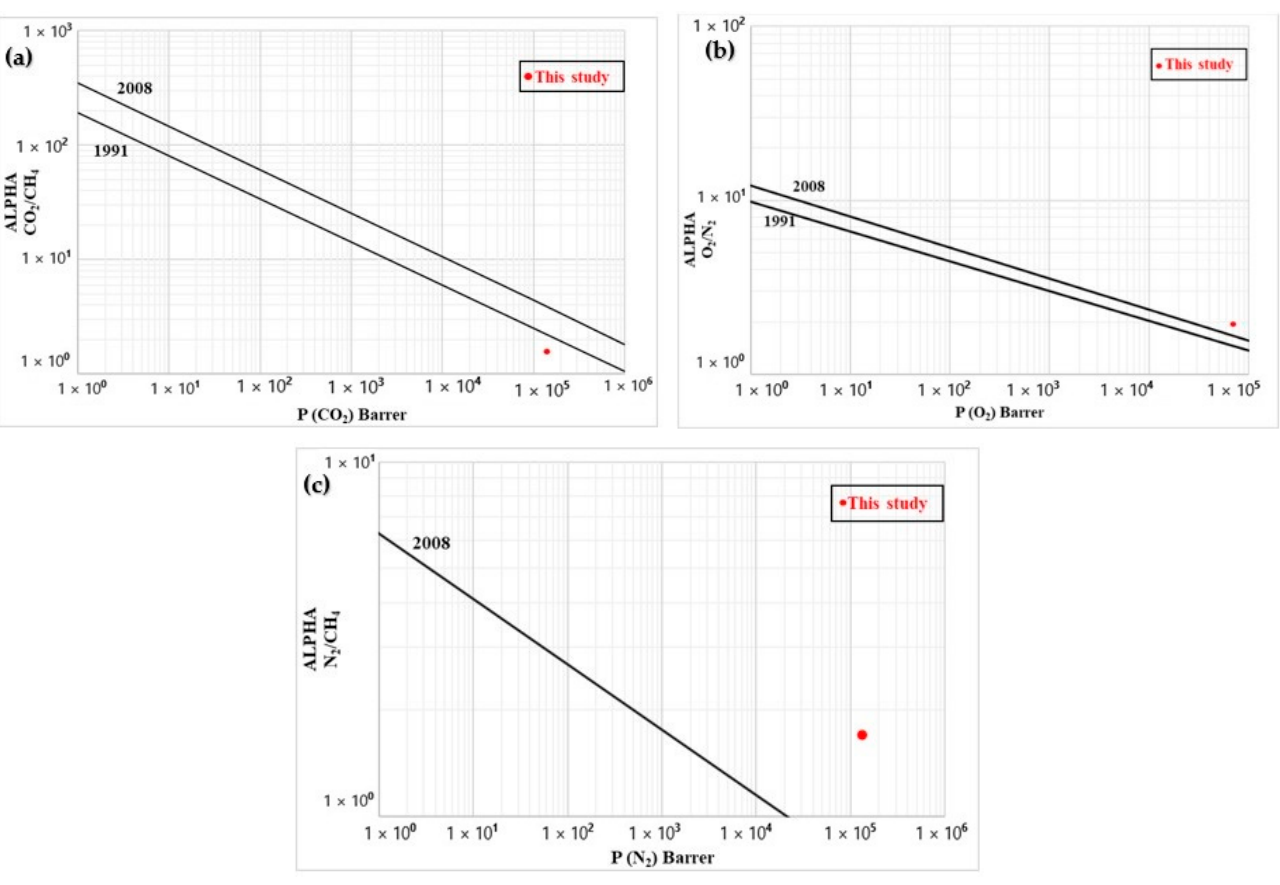
Figure 11. Comparison between the experimental data and Robeson upper bounds for ( a ) CO 2 /CH 4 , ( b ) O 2 /N 2 , and ( c ) N 2 /CH 4 . ( b ) O 2 /N 2 , and ( c ) N 2 /CH 4